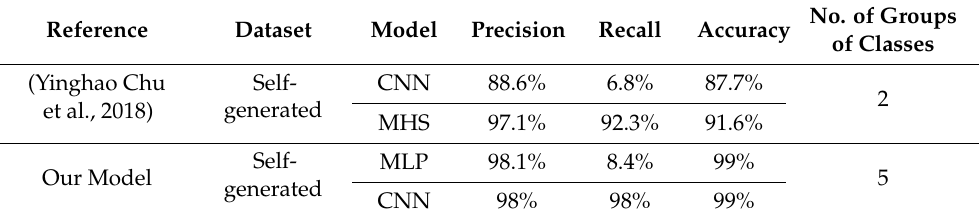
Table 5. Comparison of previous models in terms of